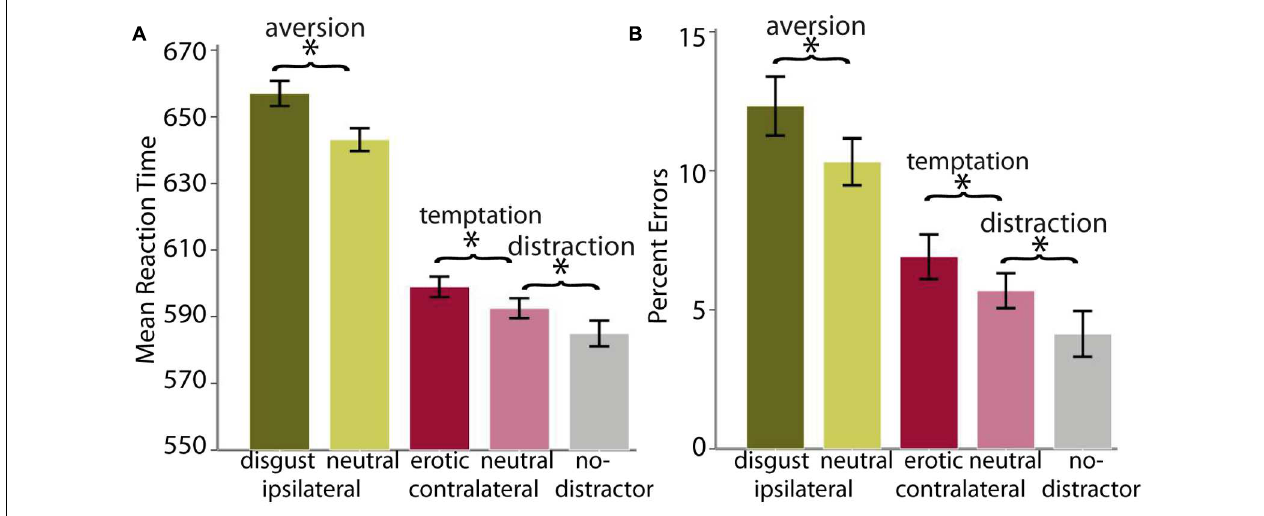
FIGURE 2 | Display of behavioral data. (A) Mean RTs and (B) percent errors. Asterisks ( ∗ ) indicate a significant difference at p < 0.05, Bonferroni corrected for the six comparisons. Error bars represent the 95% confidence interval for within-subjects comparisons (Loftus and Masson, 1994).